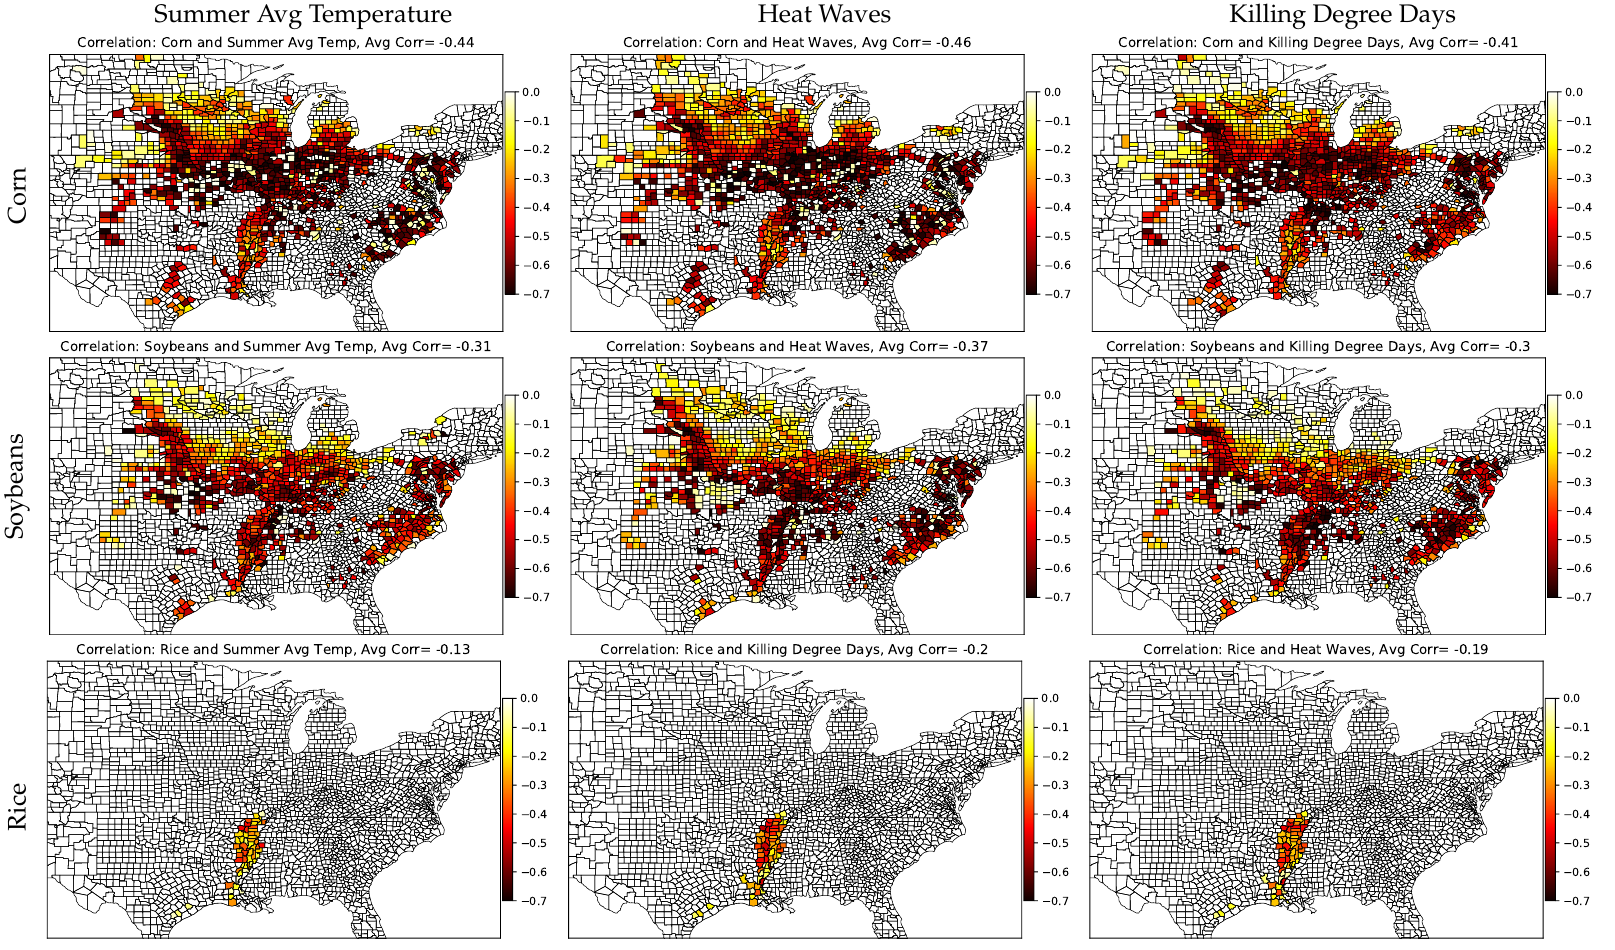
Figure 6. The same as Figure 5, but for correlations between the crop yield and the temperature metric. Correlations below − 0.49 are significant ( p < 0.05) and below − 0.59 are highly significant ( p <